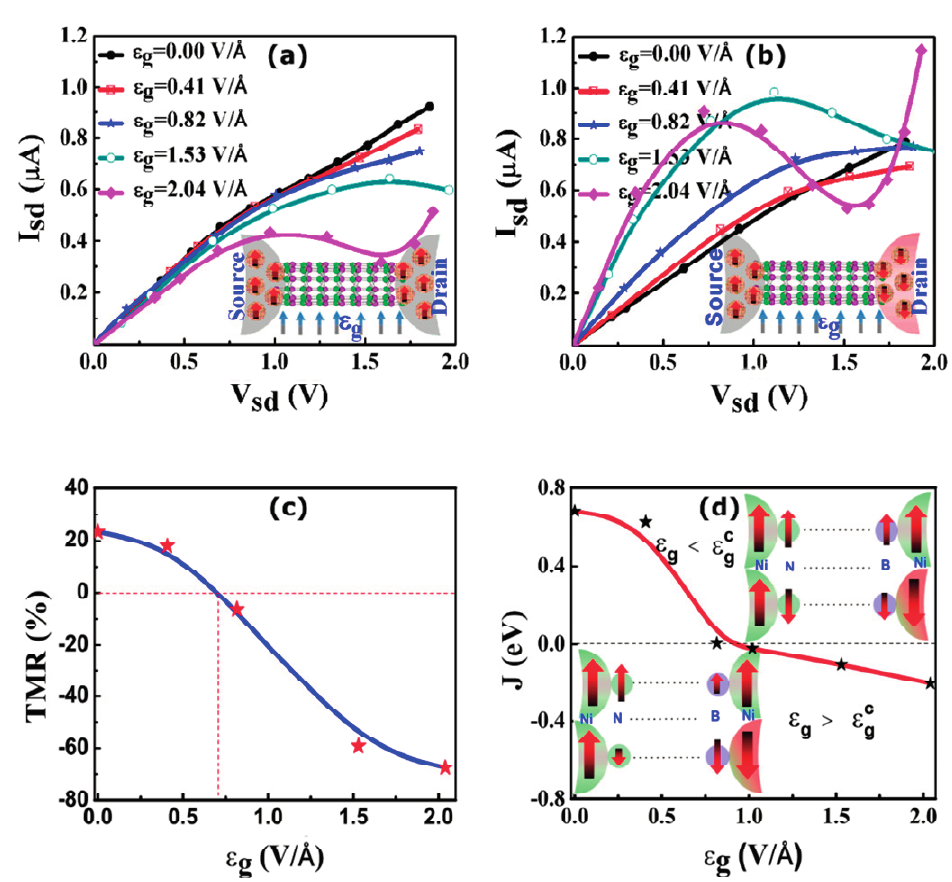
Figure 10. Switching in sign of tunnel magneto resistance (TMR) and exchange coupling (J) with transverse electric field ( ε ). I -V curves in a BNTQD tunnel junction for g sd sd ( a ) parallel (P) spin configuration and ( b ) antiparallel (AP) spin configuration as a function of ε . Insets show the schematic junction structures for the P and AP spin configurations. g at V of 0.2 V. ( d ) Exchange coupling as a function of ε ( c ) TMR vs. ε g sd ε dependent spin-profiles at the BNNT/lead interfaces. The height and width of the g